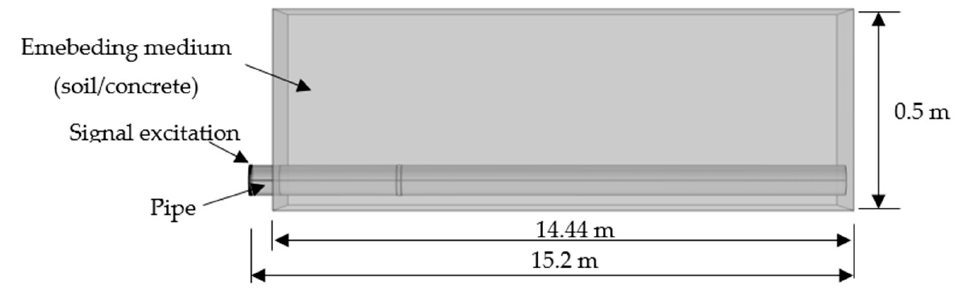
Figure 29. Model of a buried pipe.